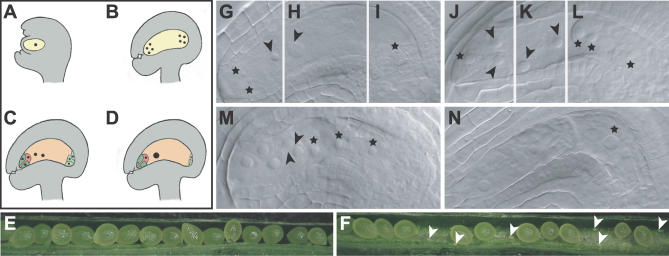
Accessory Cells in lis-1 Gametophytes Morphologically Resemble Gametic Cells(A–D) Schematic representation of wild-type female gametophyte development. Sporophytic structures are shown in grey; gametophytic structures are colored. (A) After meiosis, the haploid functional megaspore is formed. (B) A series of three mitotic divisions results in the formation of an eight-nucleate syncytium. (C) After nuclear migration and cellularization, a seven-celled gametophyte is formed containing two synergids at the micropylar end (dark green), one egg cell (red), one central cell (orange) with two polar nuclei, and three antipodal cells at the chalazal pole (light green). (D) Prior to fertilization, the two polar nuclei fuse to form one large central cell nucleus, and the antipodal cells degenerate.(E) Wild-type silique showing full seed set.(F) Silique of lis-1/LIS plants containing aborted ovules (arrowheads).(G–I) Mature wild-type gametophyte. (G) At the micropylar end, the two small synergid nuclei are detected (stars). The larger egg cell nucleus (arrowhead) is oriented towards the adjacent central cell. (H) A large central cell nucleus (arrowhead) resulting from the fusion of the two polar nuclei can be detected. (I) The antipodal cells at the chalazal end degenerate (star).(J–N) lis-1 gametophytes. (J) The synergid nuclei are enlarged and mis-polarized (star). As a consequence, synergid and egg cell become indistinguishable when lying in a similar position (arrowheads). (K) Polar nuclei are unfused (arrowheads) and occasionally ectopically cellularized (arrowheads in M). (L and M) Antipodal cells do not degenerate, but enlarge and protrude towards the center (stars). (N) Disintegration of antipodal cells and fused antipodal nuclei (star).